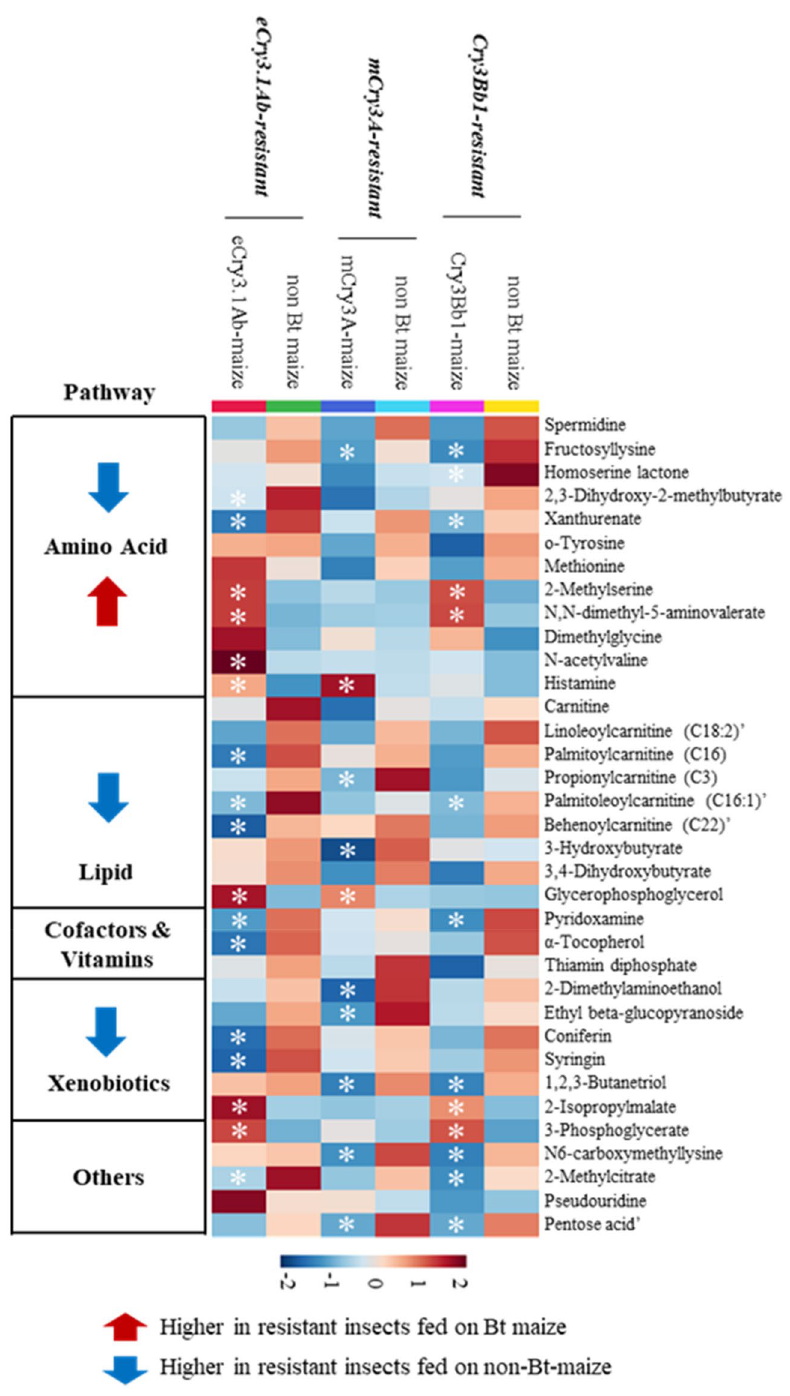
Figure 3. Heatmap for the identified metabolites expressed differently in WCR resistant larvae fed on control non-Bt maize compared with those fed on eCry3.1Ab-, mCry3A-, or Cry3Bb1-expressing maize seedlings. The metabolite annotation was confirmed with authentic standards, expected for the metabolites followed by (’) that were annotated based on their available identities (e.g., m/z , mass spectra). Asterisks (*) represent significant differences (p < 0.05) of metabolites in the resistant insect fed on their respective Bt maize with those fed on the non-Bt